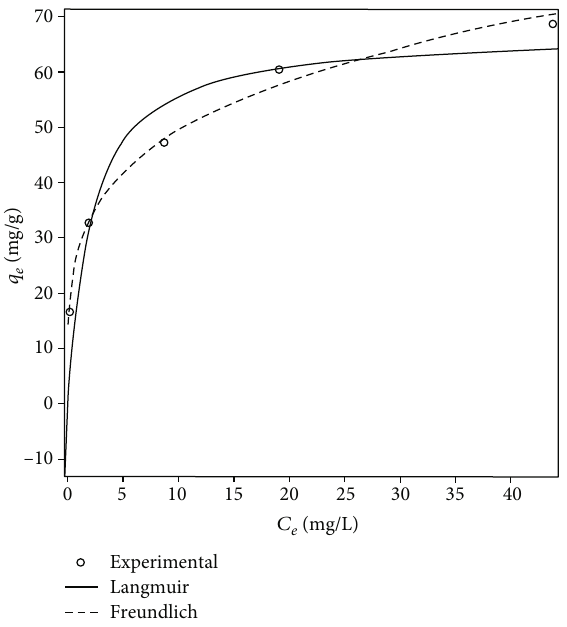
Figure 13: Isotherm study for the elimination of ARS dye by CTASP